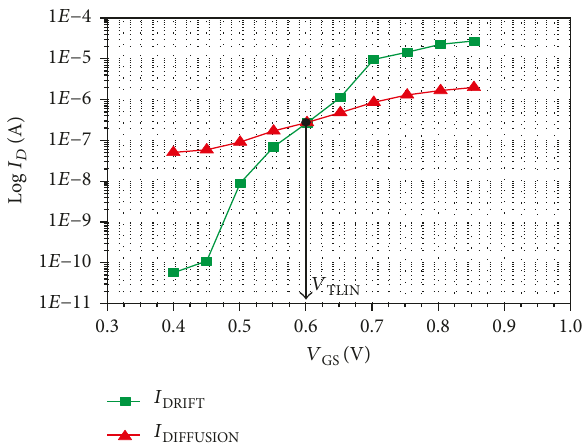
Figure 1: 10nm test device simulation results of drift current and diffusion current versus gate voltage ( V GS ) for V DS